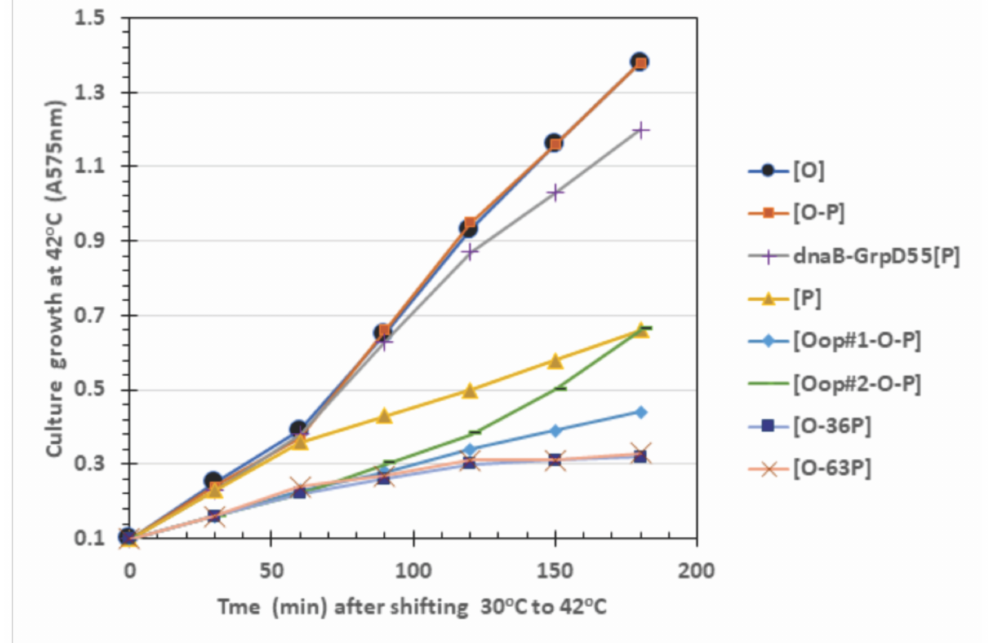
Figure 4. Influence of induced O , P gene expression on cell growth at 42 ◦ C. All the strains were made by transforming hosts 594 or 594 dnaB -GrpD55 with pcIpR-(..)-timm plasmids that included the cloned O , P DNA fragment, and selecting the transformants on LBAmp50 agar (medium composition is described in footnote to Table 3). The plasmid inserts in each CFU employed were verified by DNA sequence analysis. Cells were inoculated from overnight cultures grown up overnight in LBAmp50 broth and then 0.4 mL of culture was added to triplicate 20 mL fresh LB cultures that were incubated at 30 ◦ C for 30 min to reach an A575 = 0.1. Upon reaching an absorbance of 0.1 the cultures were transferred to a shaking 42 ◦ C water bath. Aliquots were sampled every 30 min for 3 h. The average absorbance is shown, with a standard error for each culture time of less than 5% the averaged absorbance